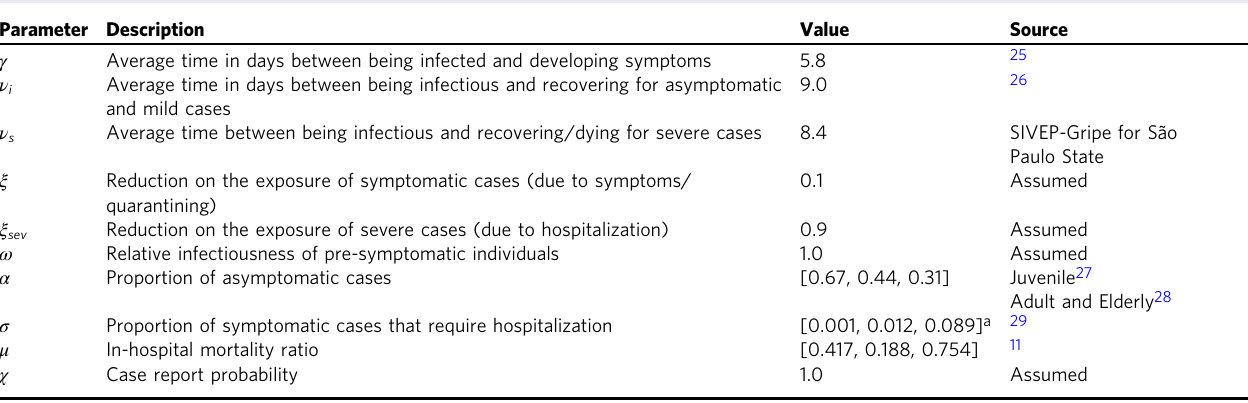
Table 1 Epidemiological